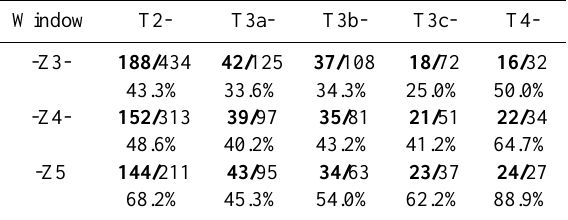
Table 3. Sum of the numbers (in bold) of upward-moving and downward moving wave packets in each window identified to be at- mospheric gravity waves by dispersion equation. The number under the slash represents the number of wave packets being measured in each respective window, and the percentage of the originally mea- sured wave packets to be identified as gravity wave packets was listed under the respective numbers. The events were obtained from summer data set.